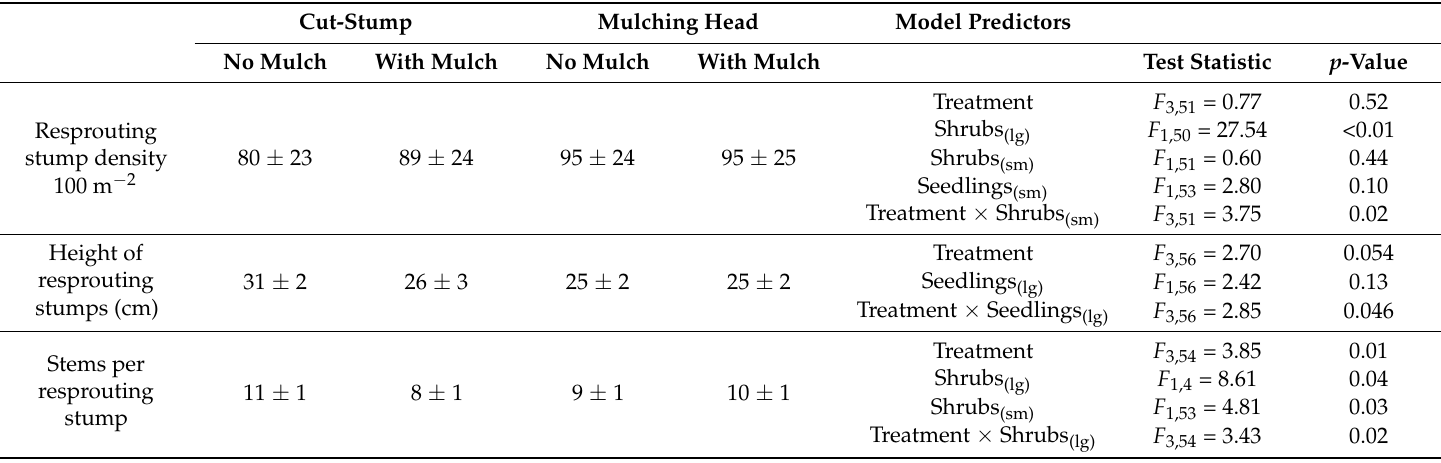
Table 2. Honeysuckle resprouting responses to cut-stump and forestry mulching head removal treatments. Models were selected using Akaike’s Information